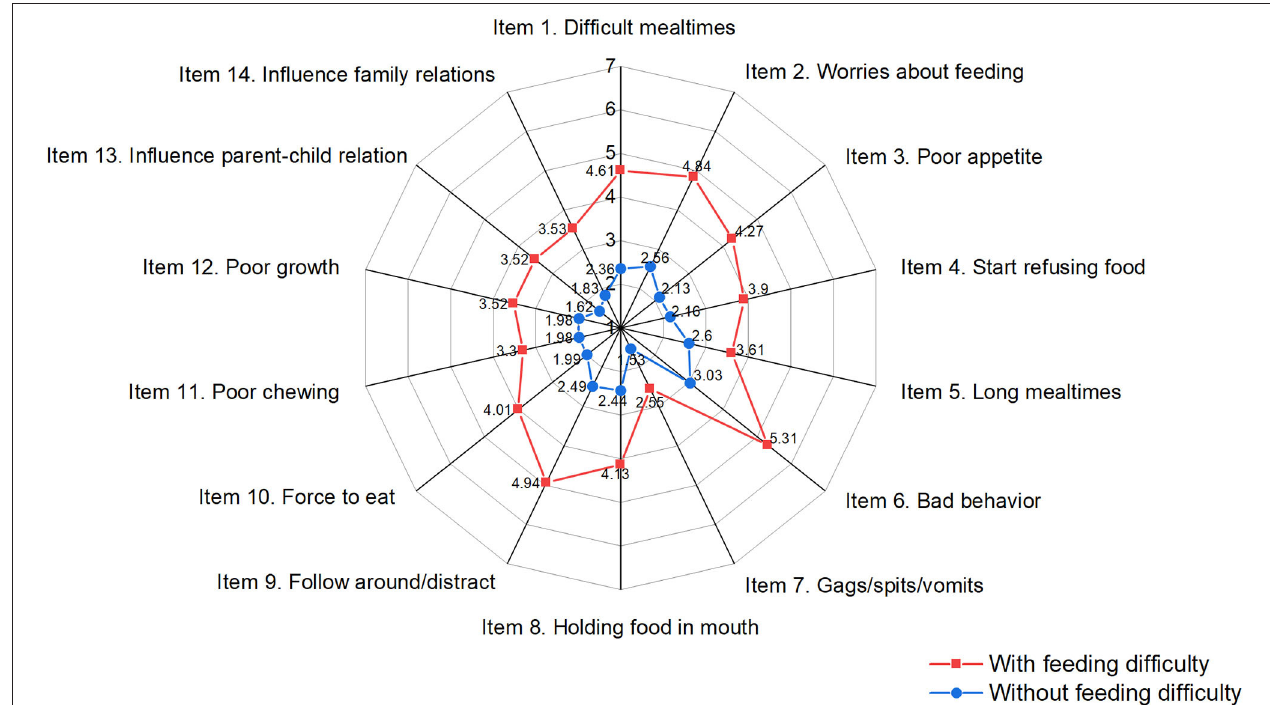
FIGURE 1 | Mean score of the 14 items of MCH-FS based on classification of feeding